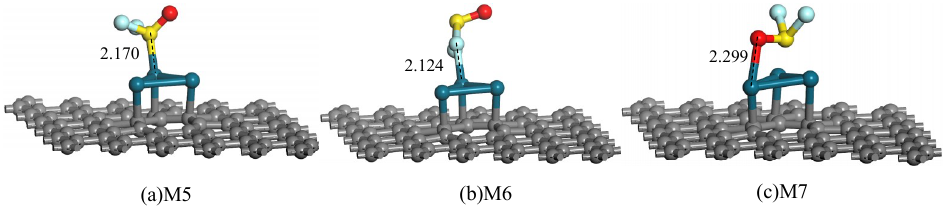
Figure 6. Adsorption structures of SOF 2 on Pd 3 -graphene surface (distance in Å). Table 3. Structural parameters of SOF 2 adsorption systems on Pd 3 -graphene surface. Position represents